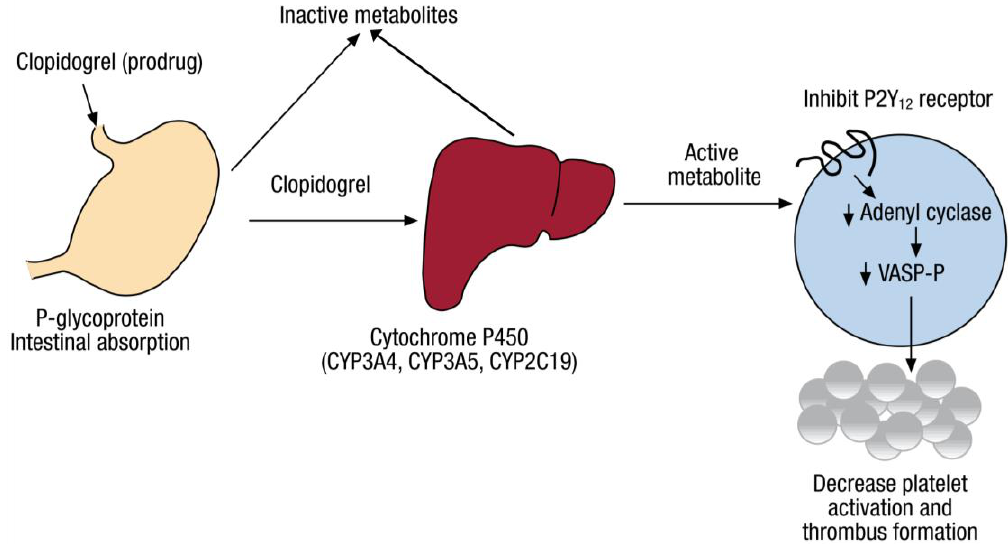
Figure 1. Metabolism of clopidogrel. The pharmacodynamics and pharmacokinetics of clopidogrel (a